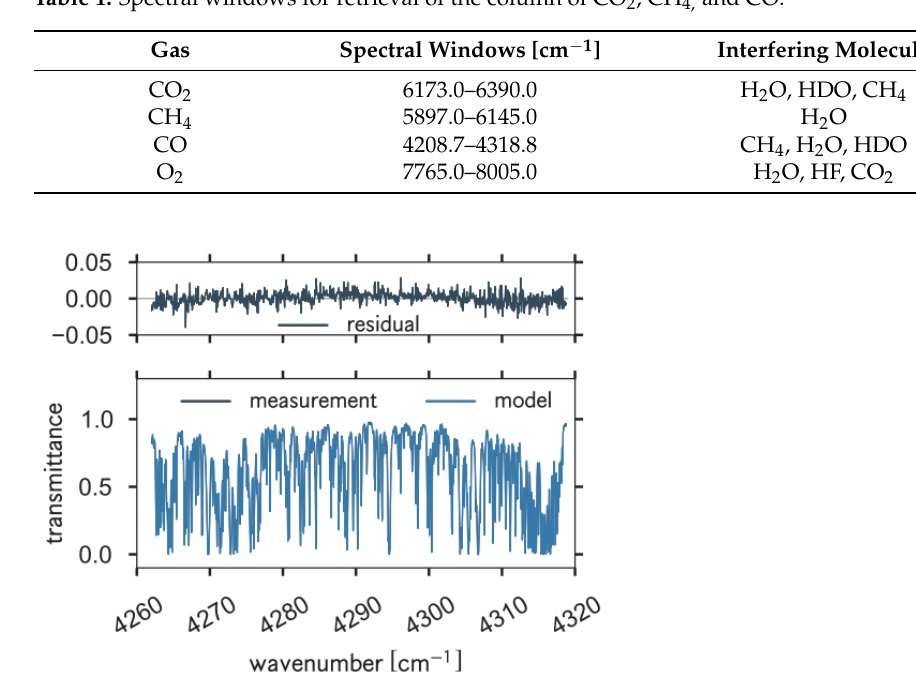
Table 1. Spectral windows for retrieval of the column of CO 2 , CH 4, and CO.